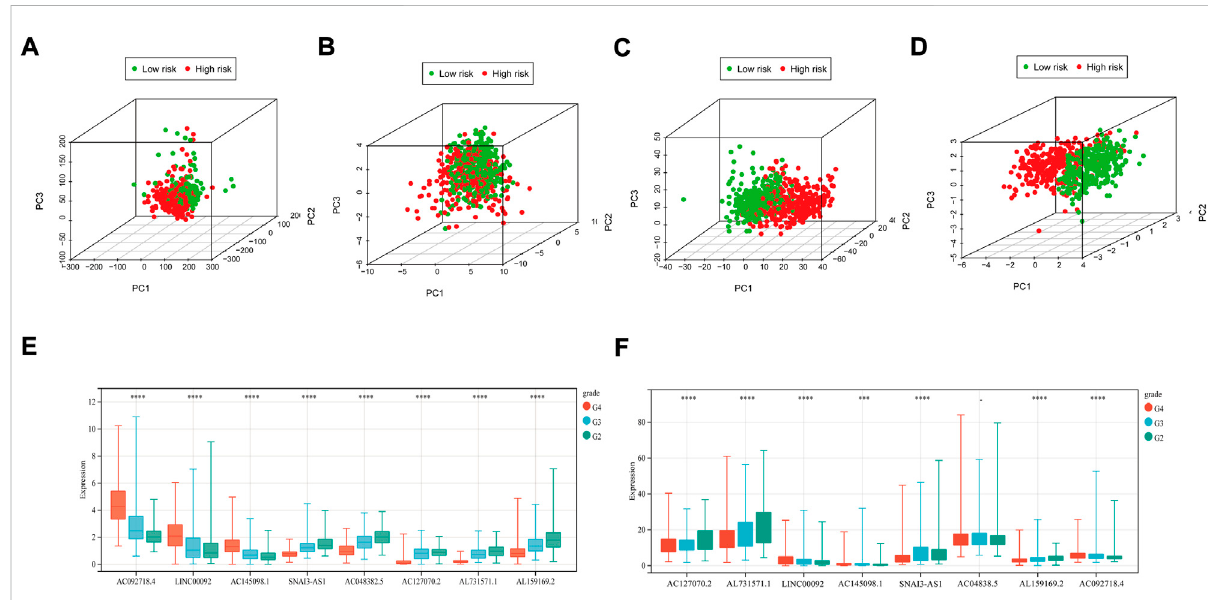
FIGURE 3 PCA maps of the TCGA glioma dataset show the distribution of patients based on the (A) whole genome; (B) m 7 G-related gene sets; (C) m 7 G-relatedlncRNAs;and (D) prognosticm 7 G-relatedlncRNAs.Red:high-risk;Greendots:low-risk.Expressionpro fi leof8prognosticm 7 G-related lncRNAswithdifferentgliomagrades. (E) m 7 G-relatedlncRNAsexpressionwithdifferentgliomagradesinTCGAdatasets. (F) prognosticm 7 G-related lncRNAs expression with different glioma grades in CGGA datasets. (G2: WHO II, G3: WHO III, G4: WHO IV). * p < 0.05, ** p < 0.01 and *** p <